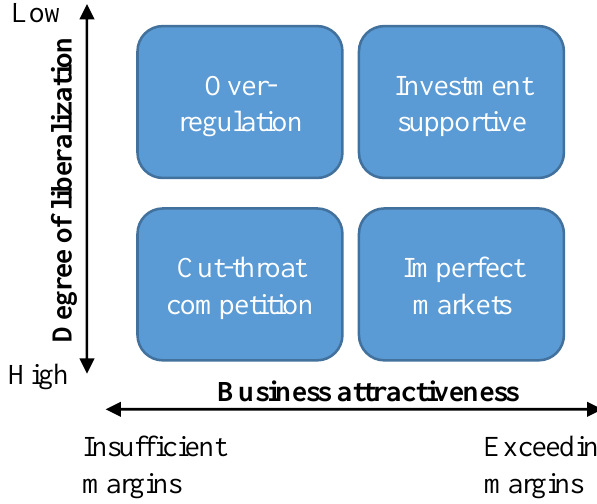
Figure 19. Margins as a function of business attractiveness and degree of liberalization. Own illustration, based on RWE internal